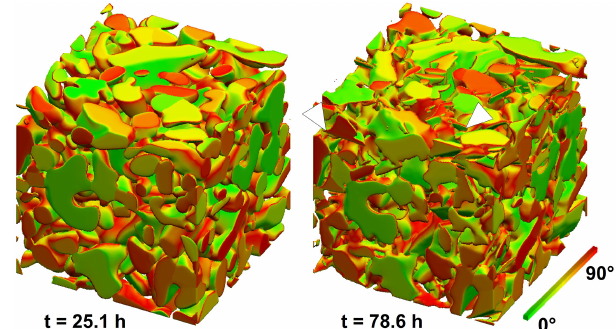
Figure 5. Grain map evolution. Each colour represents a single crystalline orientation. The meaning of the colours is given by the colour wheel, representing orientations in a pole figure centred on a vector X + Y + Z . The five axes under the colour wheel show the colour corresponding to the main directions associated with X , Y and Z .